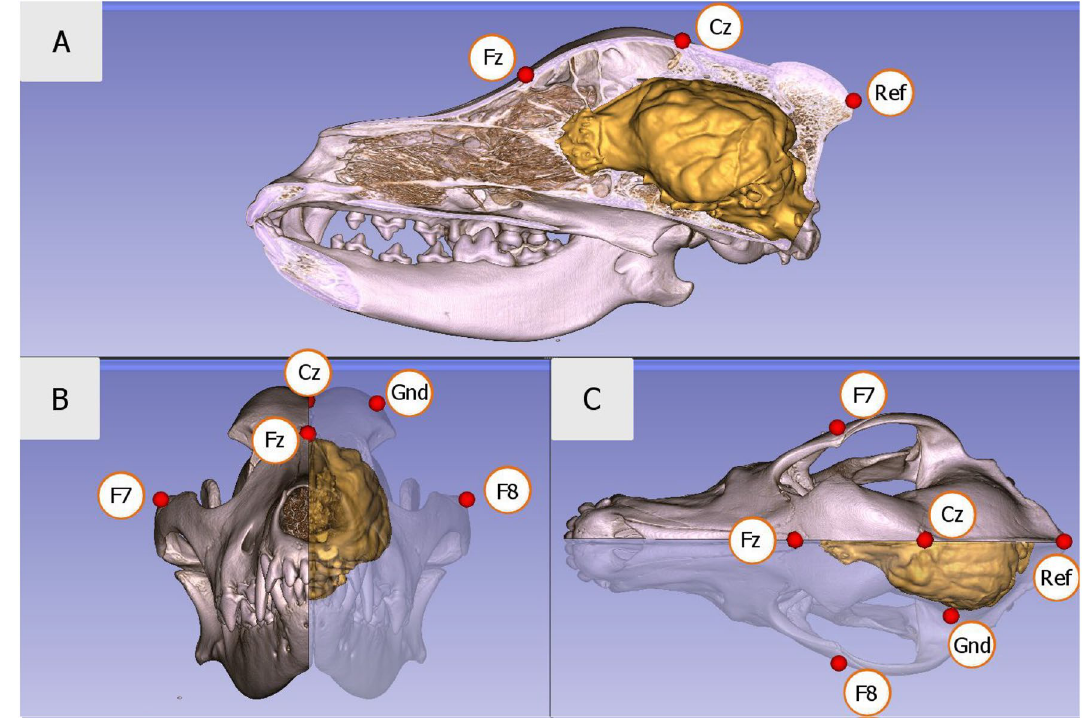
Figure 1. Positions of the electrodes relative to the three-dimensional model and endocranial cast of the skull of a pointer dog: ( A ) lateral, ( B ) anterior and ( C ) superior views, image by Kálmán Czeibert. Placement of the electrodes (Fz–Cz: frontal and central midline; F8–F7: right and left electrodes placed on the zygomatic arch; Ref: reference electrode or G2; Gnd: ground electrode or G1). In this study, the statistical analysis was performed with the Fz data only. All other electrodes were merely used to aid sleep stage